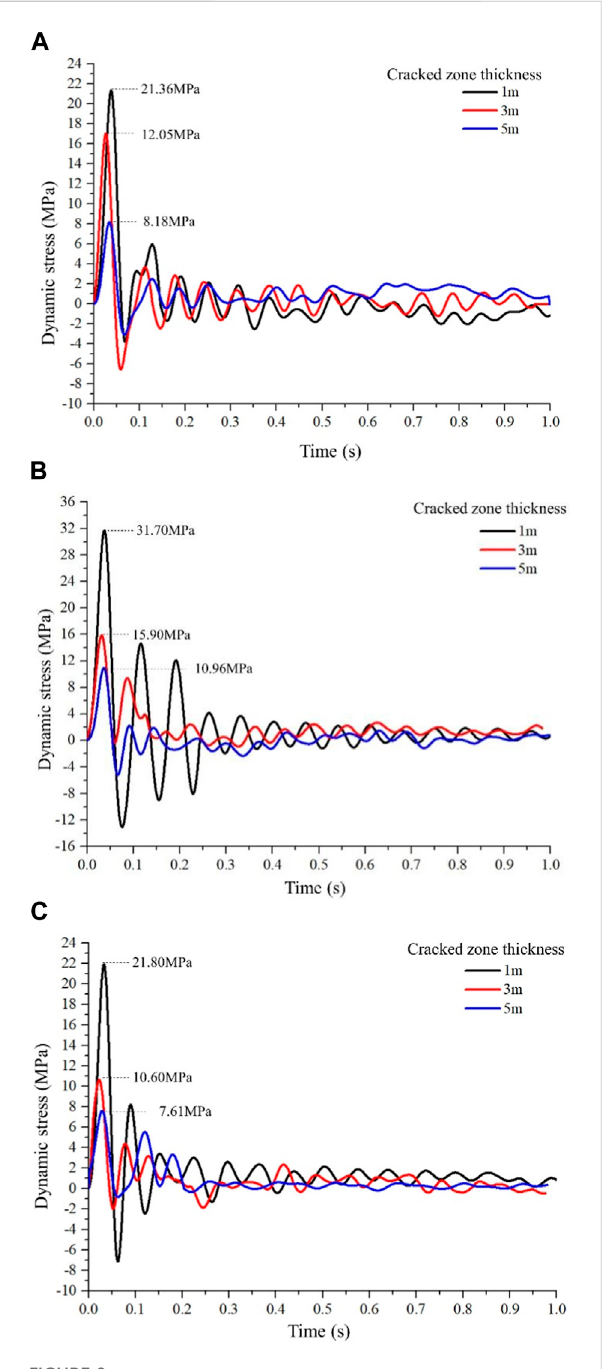
FIGURE 9 Dynamic stresses with different cracked zone thicknesses for monitoring points located at the inner wall of (A) roadway top, (B) roadway side, and (C) roadway bottom.